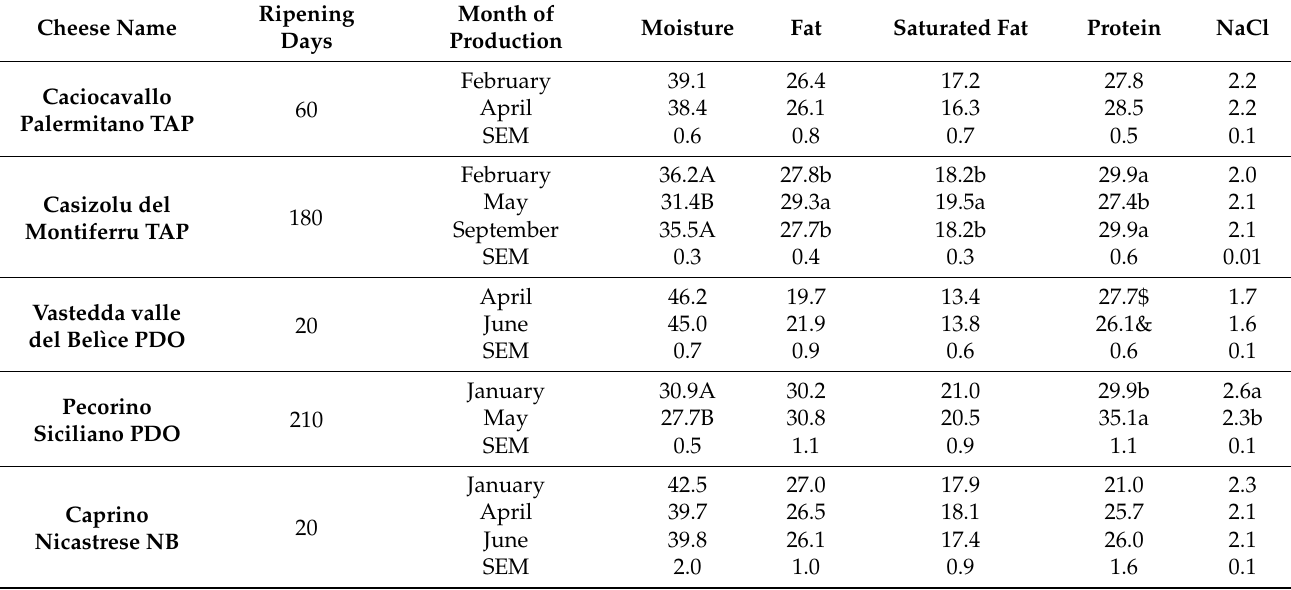
Table 2. Effect of the month of production on the gross composition of the AGER selection cheeses (g/100 g of cheese).